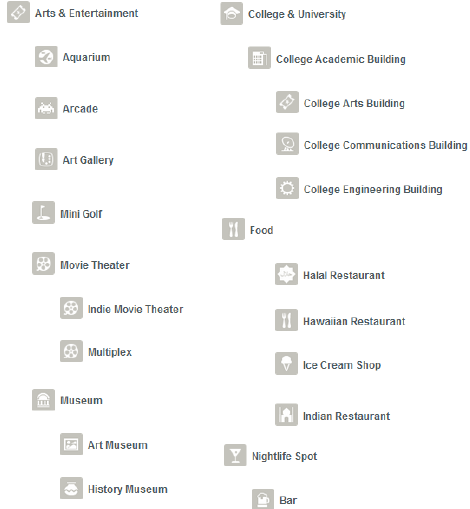
Figure 1: A sample view of some parts of location category